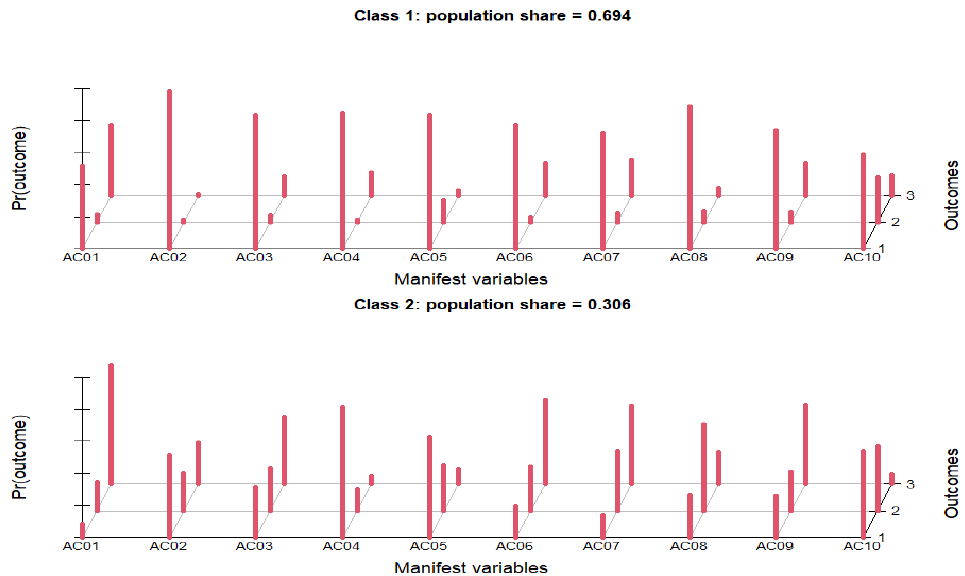
Figure 2. Attitudes towards antibiotic